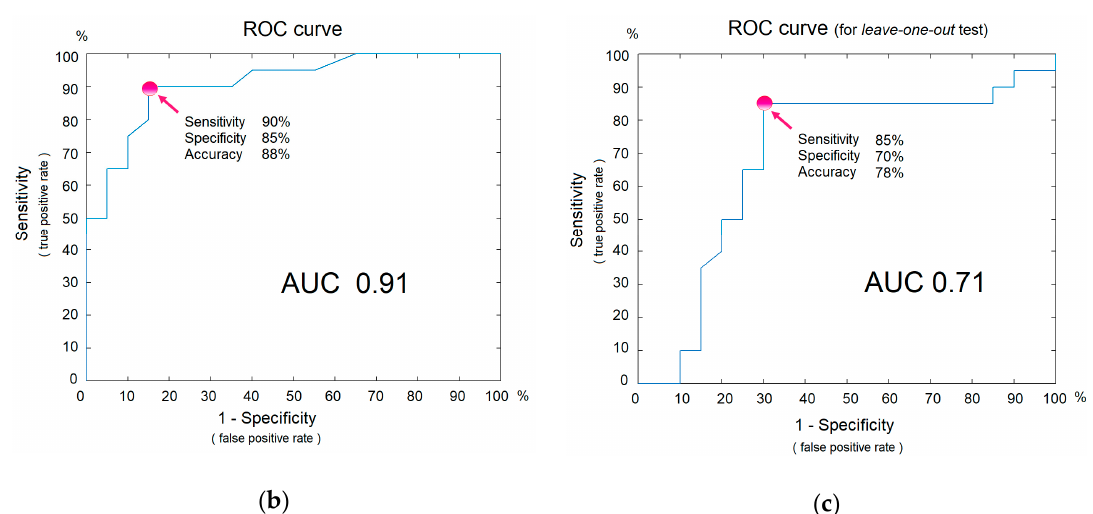
Figure 4. The e ffi ciency of in situ mass spectrometric diagnostics without labels. ( a ) Dependence of diagnostic parameters on metabolites included in the signature (i.e., on the AUC threshold for the ratio of mass peak intensities, as a criterion for inclusion in the signature). The optimal threshold is shown by the dashed line. ( b ) ROC curve for IGT diagnosis. ( c ) ROC curve for IGT diagnostics obtained using the leave-one-out test. Arrows indicate points on the ROC curve corresponding to optimal sensitivity, specificity, and accuracy of